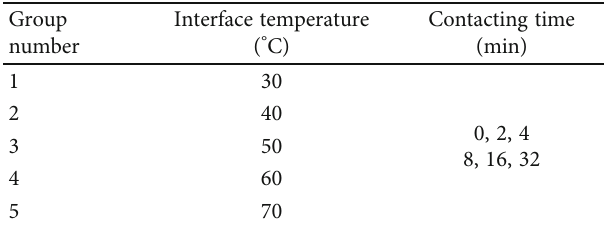
Table 2: Experimental design of e ff ect of contacting time on soil